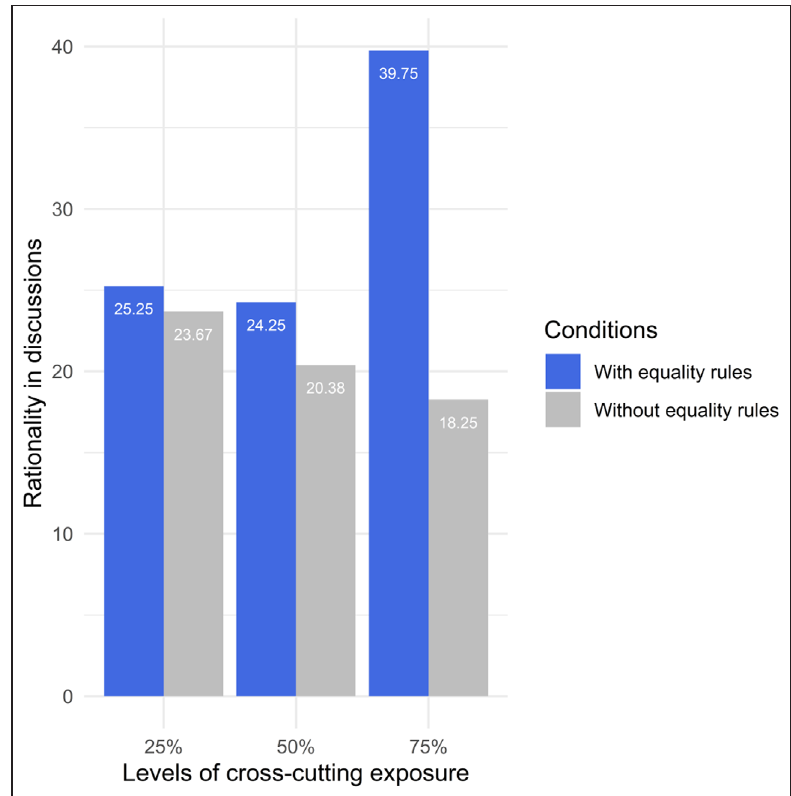
Figure 1: Rationality in different deliberative conditions. Note : Greater values indicate a greater level of reason-giving from participants. Table 4: Effects of cross-cutting exposure and the rule of equality on political participation and civic